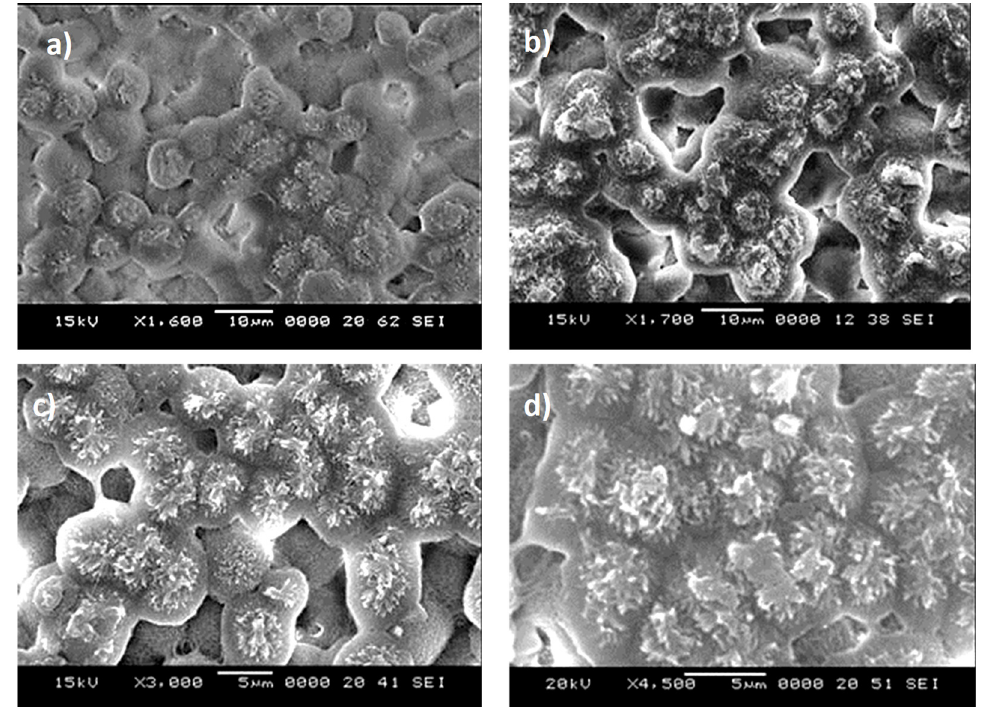
Figure 1. Scanning electron microscope (SEM) micro-images of solution treated polycarbonate: ( a ) spherules formed on sample surface after 2 min of treatment, ( b ) spherules formed on sample surface after 6 min of treatment, ( c ) fibrils emanating from spherules surface after 2 min of treatment, ( d ) fibrils emanating from spherules surface after 6 min of treatment.